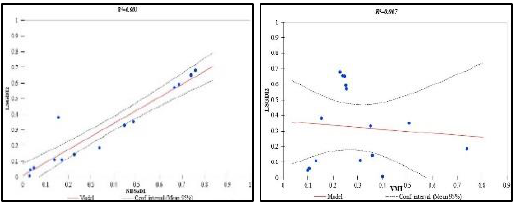
Figure 14. Regression of LSGDI by NDSoDI (left) and VMI